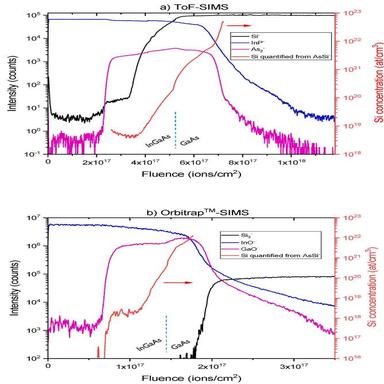
a) ToF-SIMS and b) Orbitrap™-SIMS profiles recorded on 16 nm wide InGaAs/GaAs fins (quantified Si using AsSi− ).